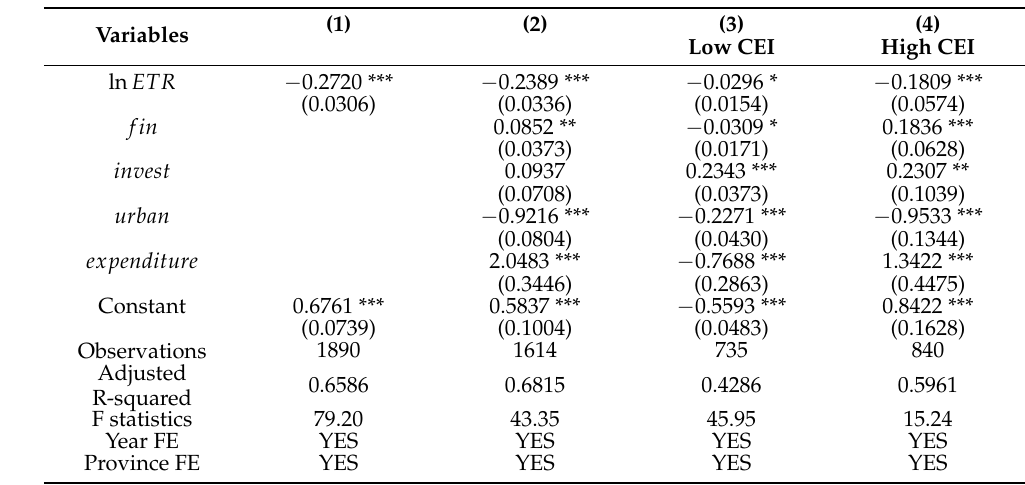
Table 2. Baseline model.